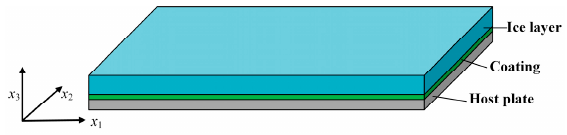
Figure 1. Schematic of a general three-layer plate model.